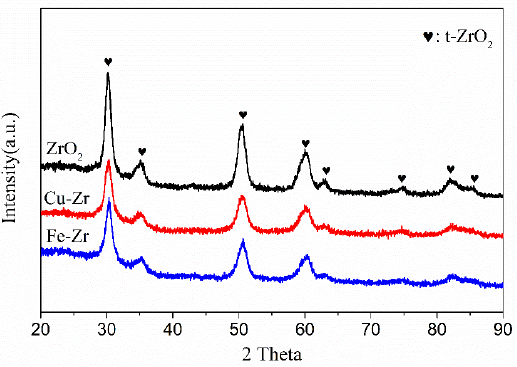
Figure 1. X-ray diffraction (XRD) diffractograms of ZrO 2 support, Cu-Zr and Fe-Zr calcined catalysts. Table 1. Structural and textural properties of ZrO 2 , Cu-Zr and Fe-Zr calcined catalyst.